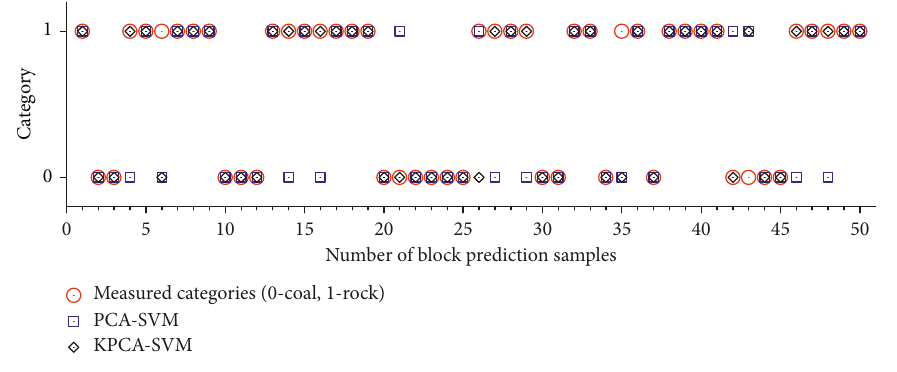
Figure 13: Prediction results of 50 nature block samples by PCA-SVM and GRB-KPCA-SVM models. Table 4: Identification accuracies of categories of all bituminite and carbonaceous shale samples collected from Malan coal mine area in Shanxi province of China by the prediction